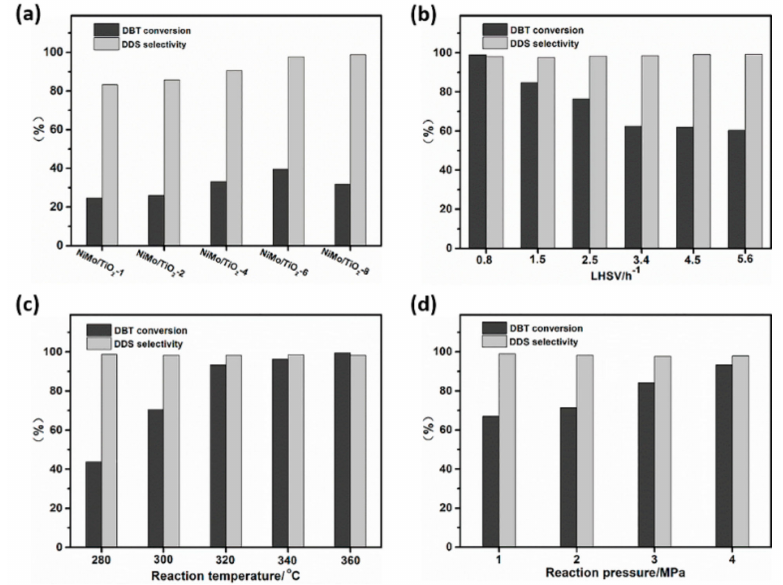
Figure 7. DBT conversion and direct desulfurization pathway ( DDS ) selectivity of ( a ) di ff erent NiMo / TiO 2 catalysts (0.33 g catalyst, 300 ◦ C, 2 MPa, LHSV of 5.6 h − 1 , H 2 / oil ratio of 606), ( b ) NiMo / TiO 2 -6 catalyst at various LHSV values (0.75 g catalyst, 300 ◦ C, 2 MPa, LHSV of 0.8–5.6 h − 1 , H 2 / oil ratio of 606), ( c ) NiMo / TiO 2 -6 catalyst at various reaction temperatures (0.75 g catalyst, 280–360 ◦ C, 2 MPa, LHSV of 5.6 h − 1 , H 2 / oil ratio of 606), ( d ) NiMo / TiO 2 -6 catalyst at various reaction pressures (0.75 g catalyst, 300 ◦ C, 1–4 MPa, LHSV of 5.6 h − 1 , H 2 / oil ratio of